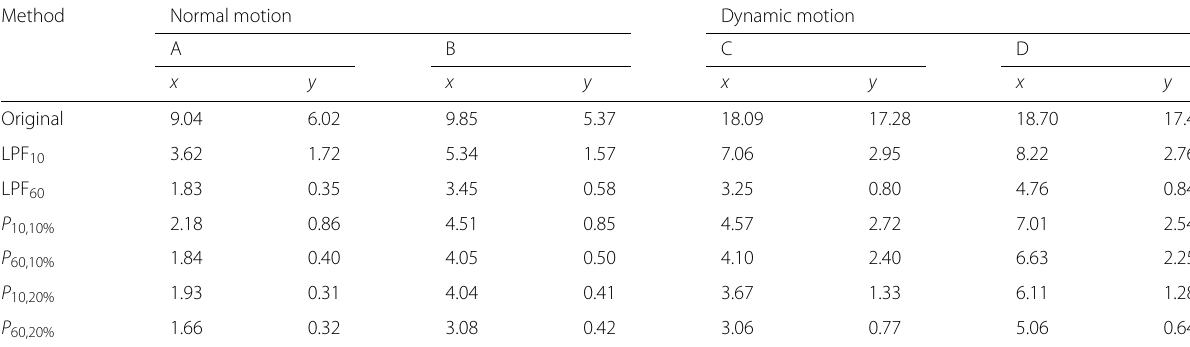
Table 2 Comparisons of mean absolute slopes Method Normal motion Dynamic